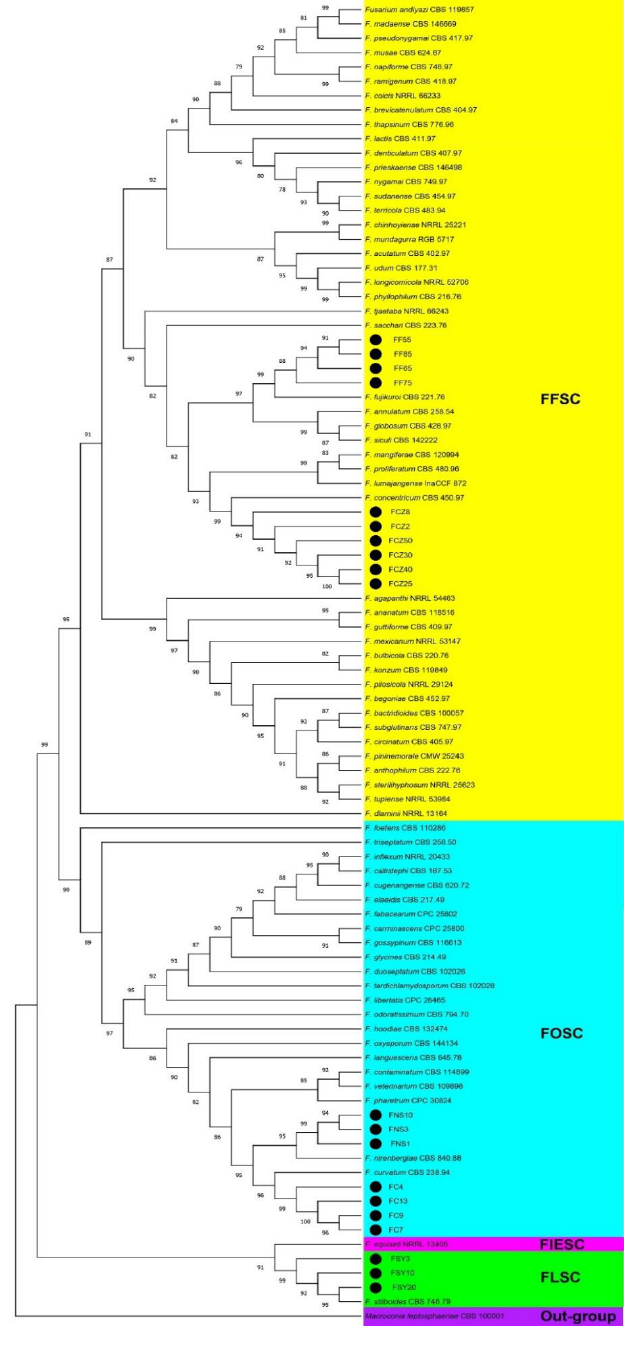
Figure 3. Multilocus phylogenetic tree resulting from maximum likelihood analysis of concatenated rpb2 , tef1 , and tub2 sequences. The tree shows the phylogenetic relationships of Fusarium spp. causing dieback disease in Dendrobium officinale . Isolates recovered from Tiepishihu in this study are indicated by a black circle ( • ). Clades including isolates obtained from D. officinale are shaded in color. The tree is rooted to Macroconia leptosphaeriae CBS 100001. Bootstrap values are shown above the branches. Subdivision of the Fusarium clade represents the recognized species